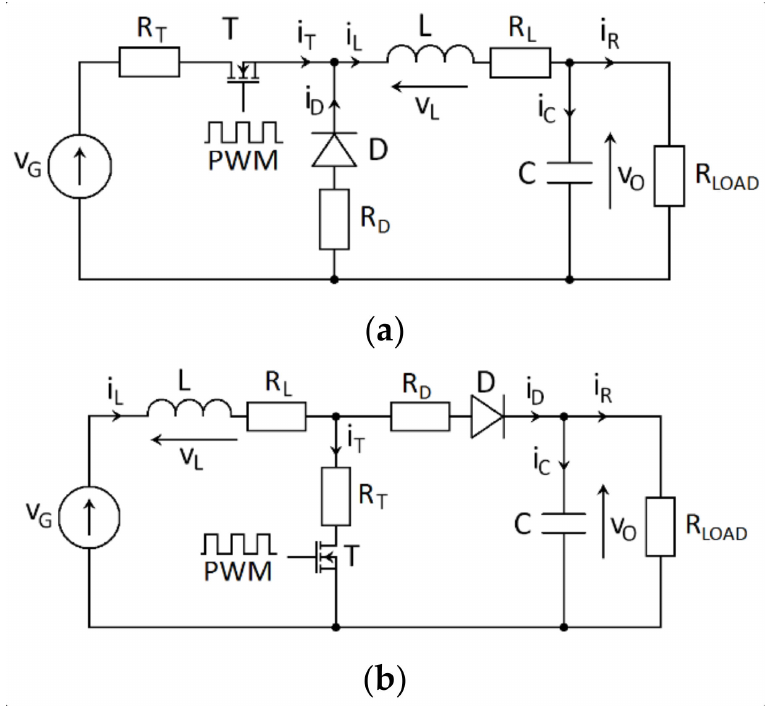
Figure 3. Converters with parasitic resistances: ( a ) buck and ( b )